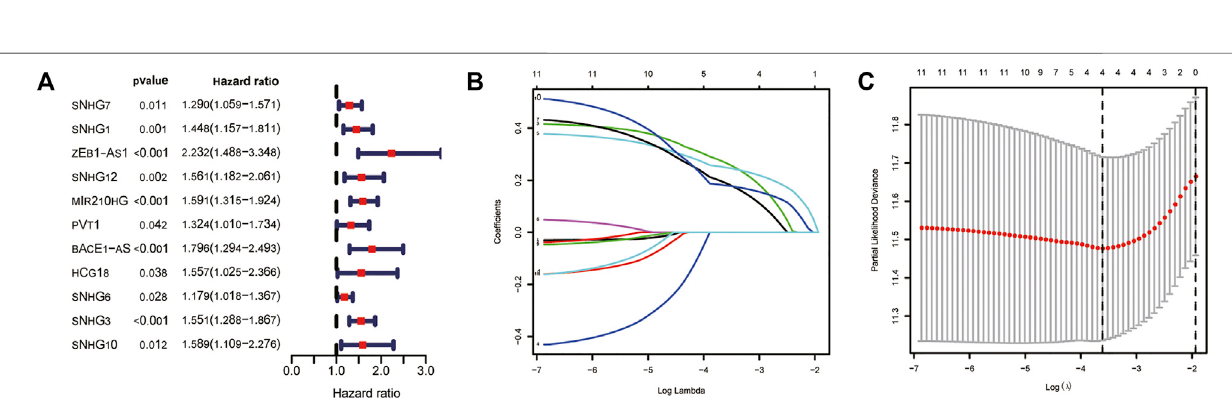
FIGURE 1 | Flowchart of the research. HCC, Hepatocellular carcinoma; TCGA, The Cancer Genome Atlas; ICGC, International Cancer Genome Consortium.